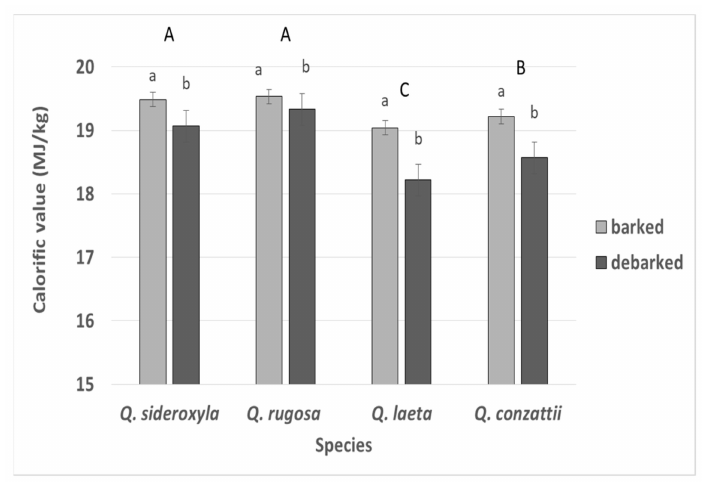
Figure 4. Calorific value of four barked and debarked oak species (bars with di ff erent letters correspond to statistically di ff erent calorific values; p <